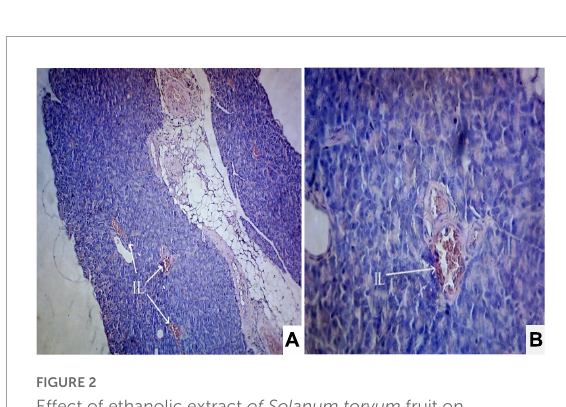
FIGURE2 Effect of ethanolic extract of Solanum torvum fruit on histopathology of pancreas in streptozotocin (STZ)-induced diabetic Sprague–Dawley rats (SD rats). Photomicrograph of a STZ-induced diabetic rat section from pancreas (diabetic control group) showed severe decrease in number of islets of Langerhans cells and β -cells. The acinar cells are seen to be normal. (A) H & E 10X; (B) H & E 40X. IL, islets of Langerhans cells.